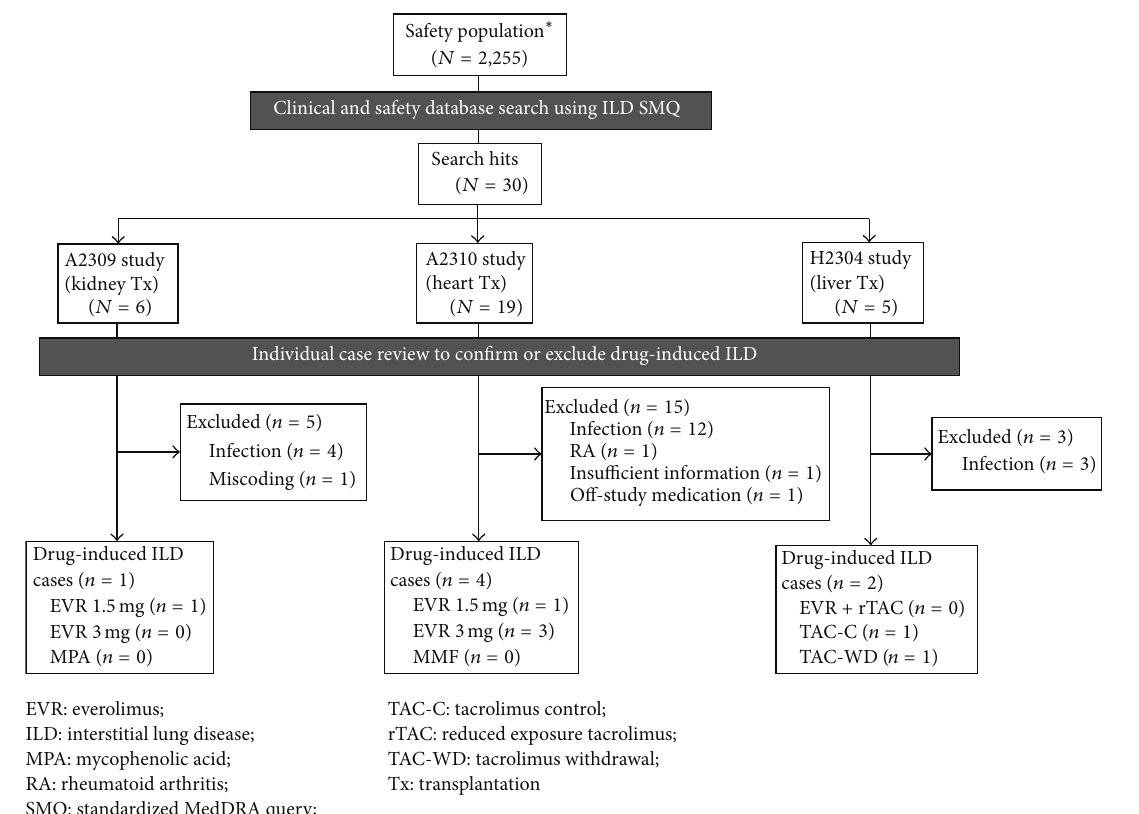
Figure 1: Clinical and safety database search flow diagram (studies A2309, A2310, and